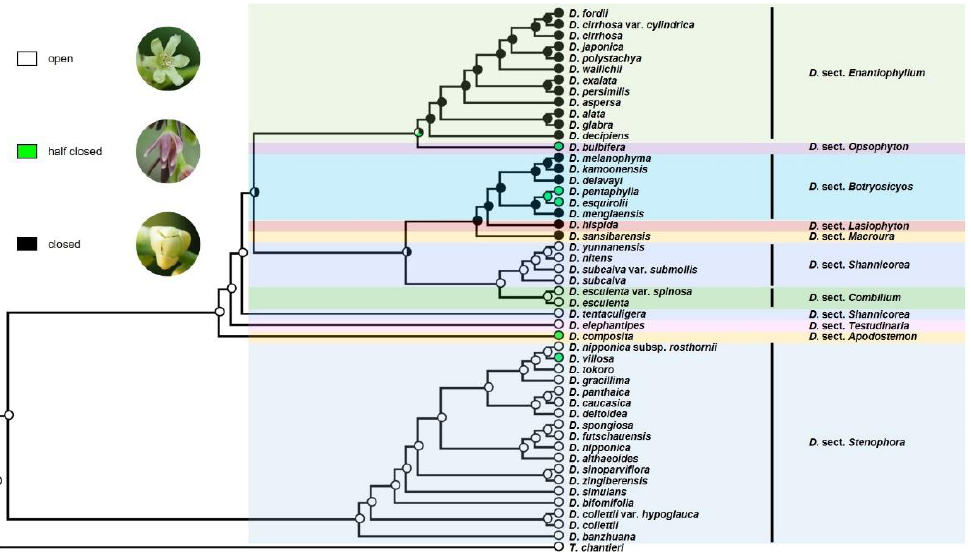
Figure 6. Ancestral character state reconstruction for the perianth opening degree using the parsimony method.